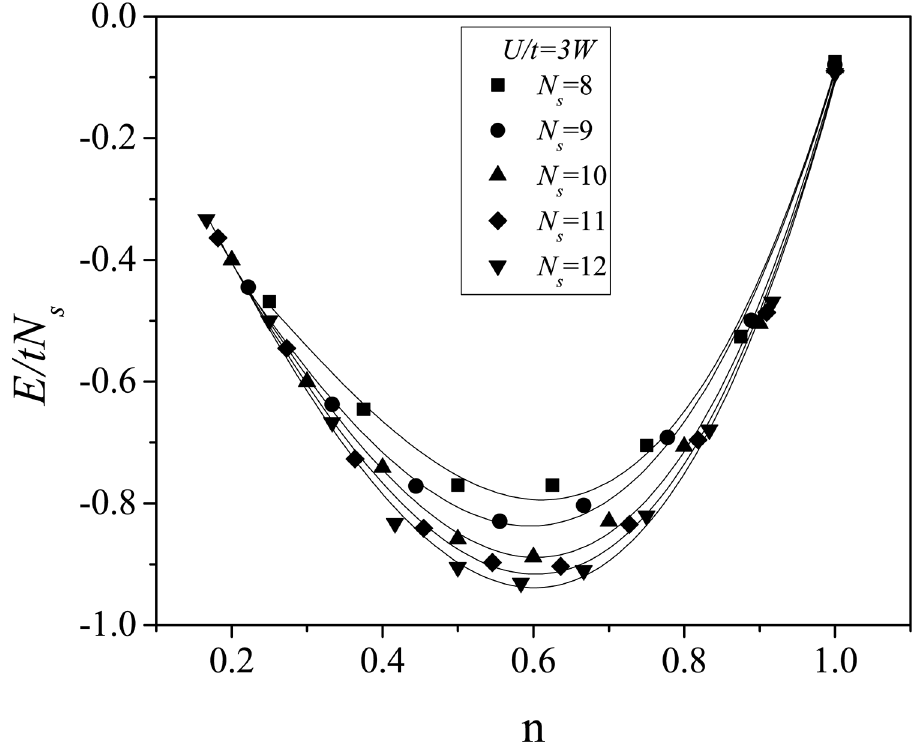
Fig 3. Ground-state energy per site for an fcc cluster as a function of the particle density n for U / t = 3 W . The number of sites N s varies from 8 to 12. The solid lines are guides for the eye.